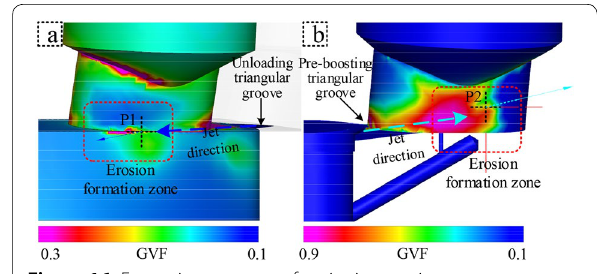
Figure 16 Formation moment of cavitation